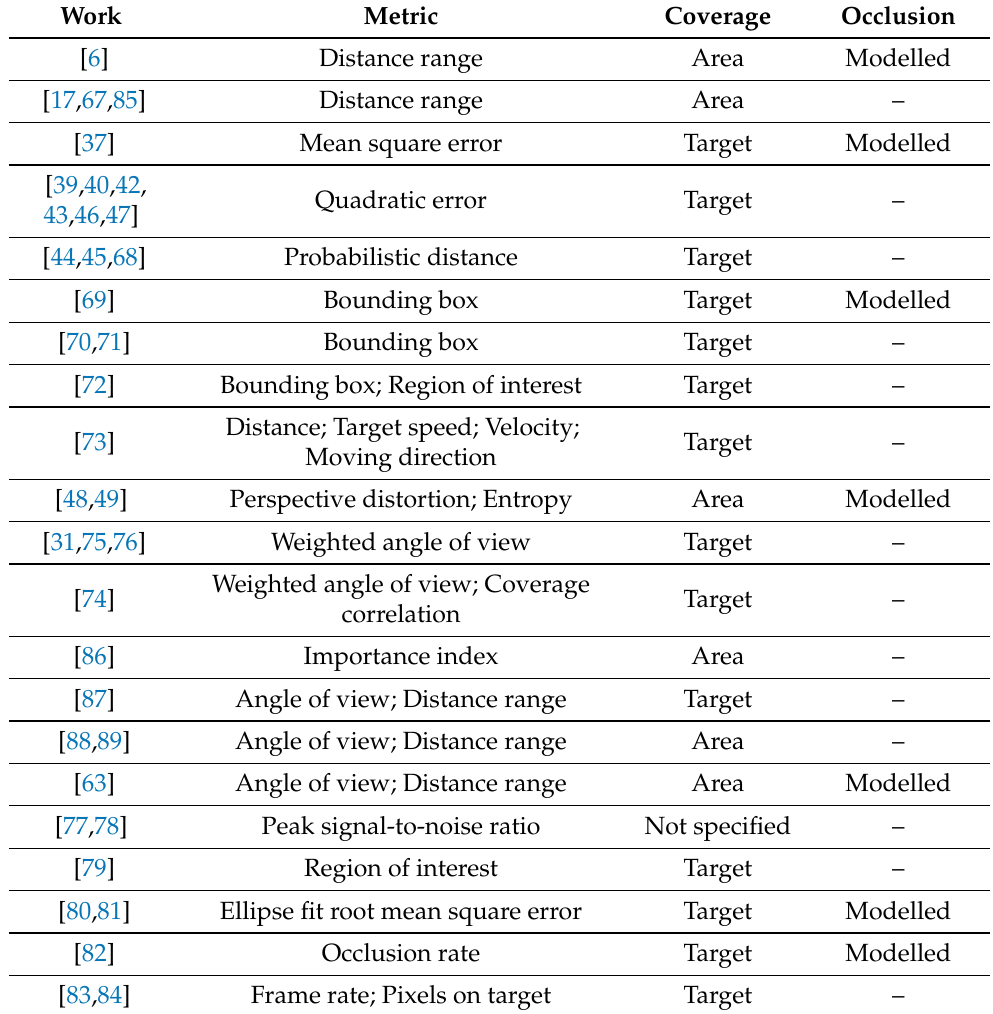
Table 2. Summary of the performed content quality